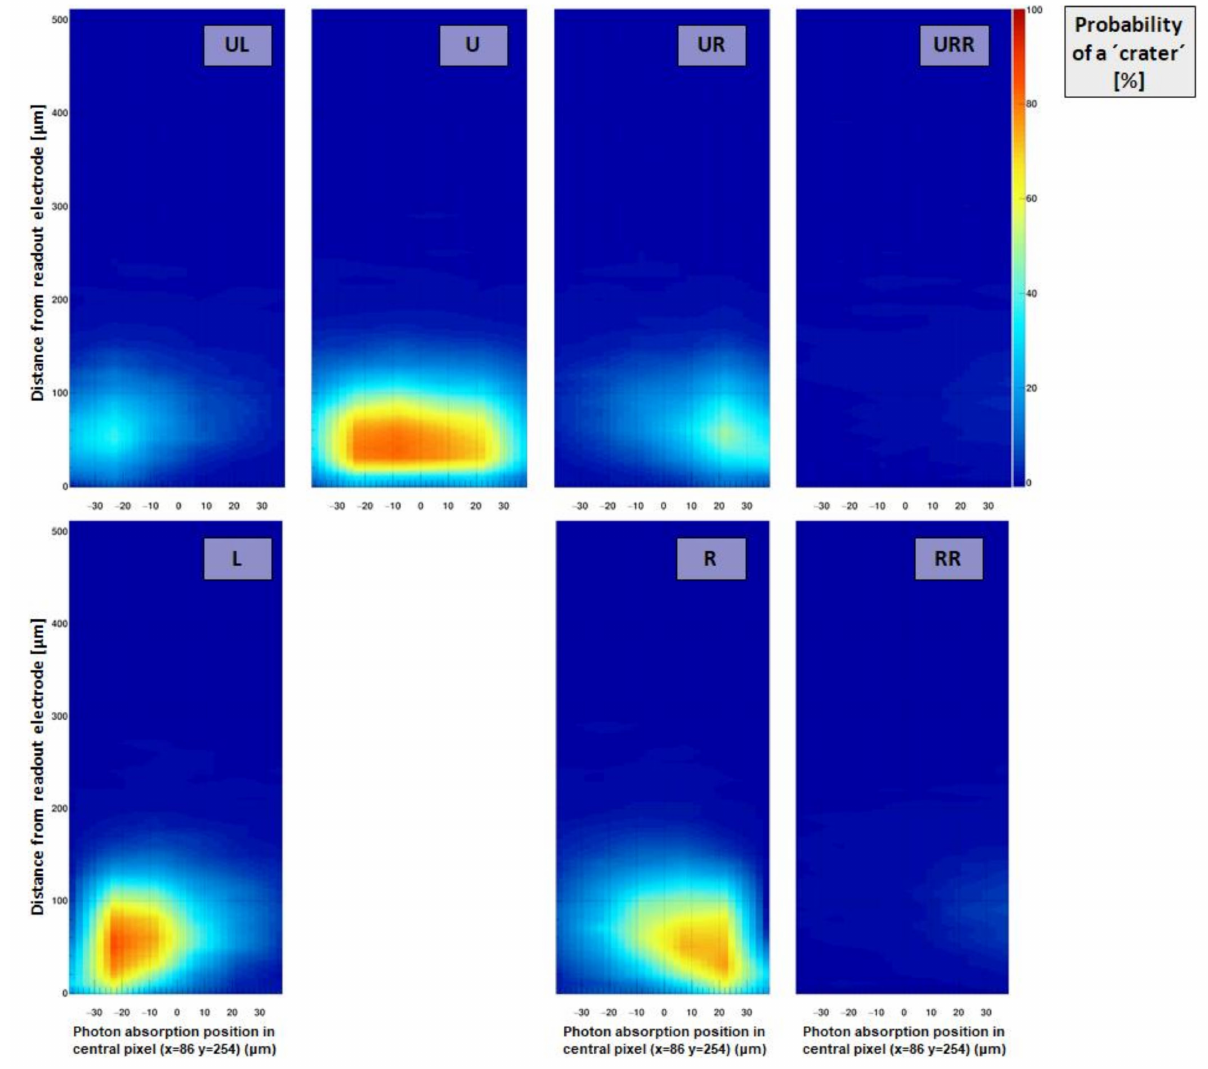
Figure 15. Relative number (or “crater probability”) of hits causing a strongly negative signal (< − 5 × pixel noise) depending on the interaction point in the pixel under investigation for different pixels in the direct neighborhood. The directly adjacent pixels (R/U/L) exhibit high probabilities close to 100%, when photons are deposited close to the readout electrode. The crater probability drops close to the pixel boundaries (at ± 37.5 µ m) due to enhanced charge sharing. Note: Compared to Figure 14, where the pixel response is shown as function of absorption position in the pixel itself, this plot indicates the pixel response of a pixel in the vicinity of the irradiated pixel as function of the absorption position within the pixel which is being